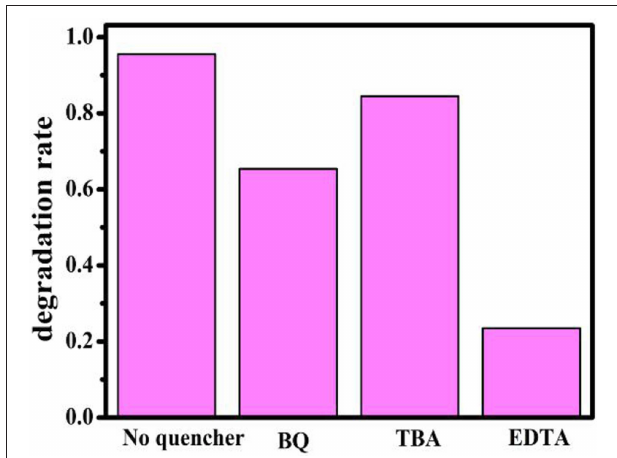
FIGURE 9 | Trapping experiment of active species under visible-light